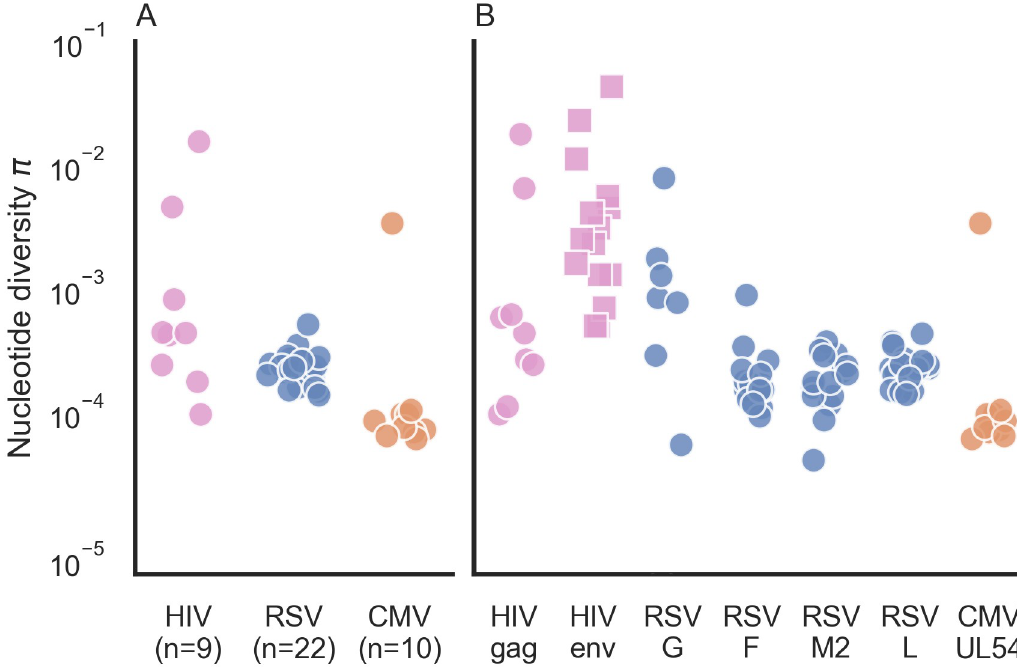
Fig 1. Nucleotide diversity π for acute infections across different virus samples and genes. (A) Each point represents the π diversity of a single sample, across all genes sequenced. Diversity values were calculated using transition mutations only. (B) Gene by gene breakdown of nucleotide π diversity. “gag” represent the gag-pol reading frame. Values for HIV envelope (env) (squares) were taken from previously published data [15].